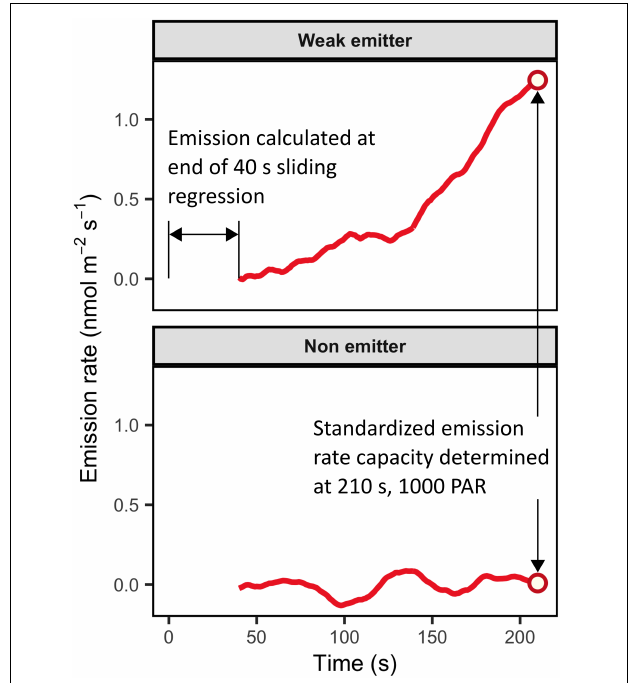
FIGURE 14 | Leaf emission rates are calculated as non-steady-state fluxes based on concentration changes determined by a 40 s sliding-window regression. Background signal noise produces noise in emission estimates around ± 0.2 nmol m − 2 s − 1 . Emission rates of 0.4 nmol m − 2 s − 1 by 210 s of measurement time are clearly differentiable from